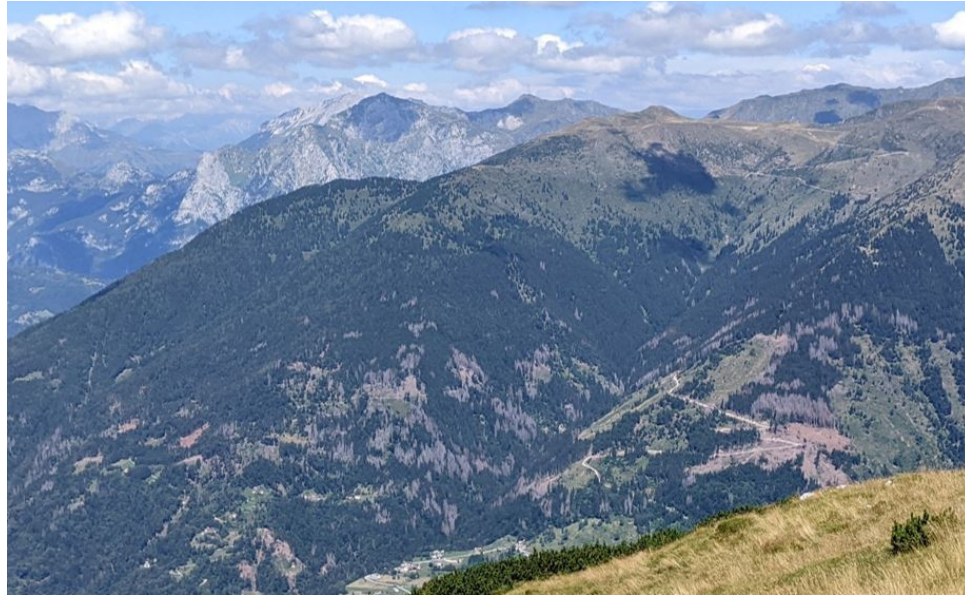
Figure 1. An example of combined abiotic (wind-felled patches) and biotic (bark beetle infestations) disturbances in Norway spruce stands at a site located in the Carnic Alps (picture taken from Mount Tersadia, 1960 m a.s.l.).